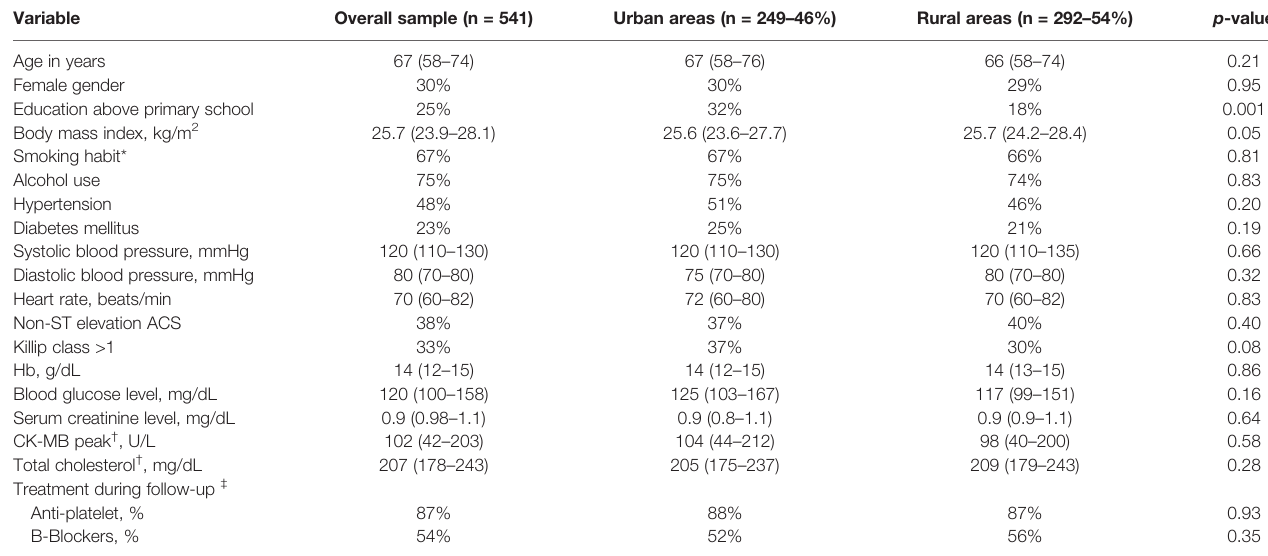
TABLE 1 | Demographic and clinical characteristics of patients with ACS who were discharged alive, according to the geographic area of residency. Variable Overall sample (n = 541)